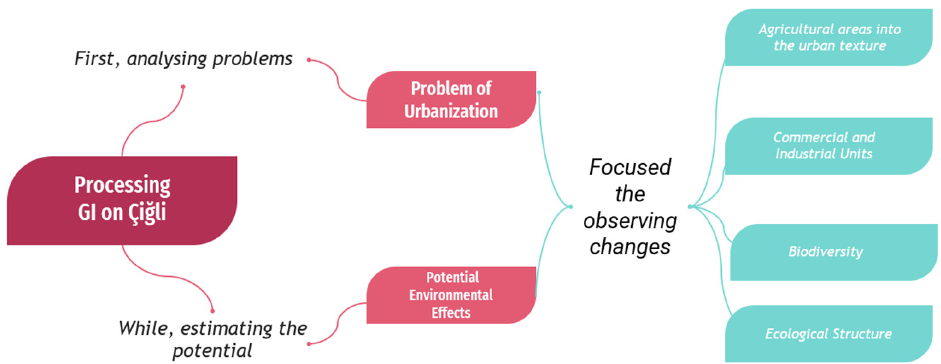
Figure 1. Logical workflow (source: author’s elaboration).